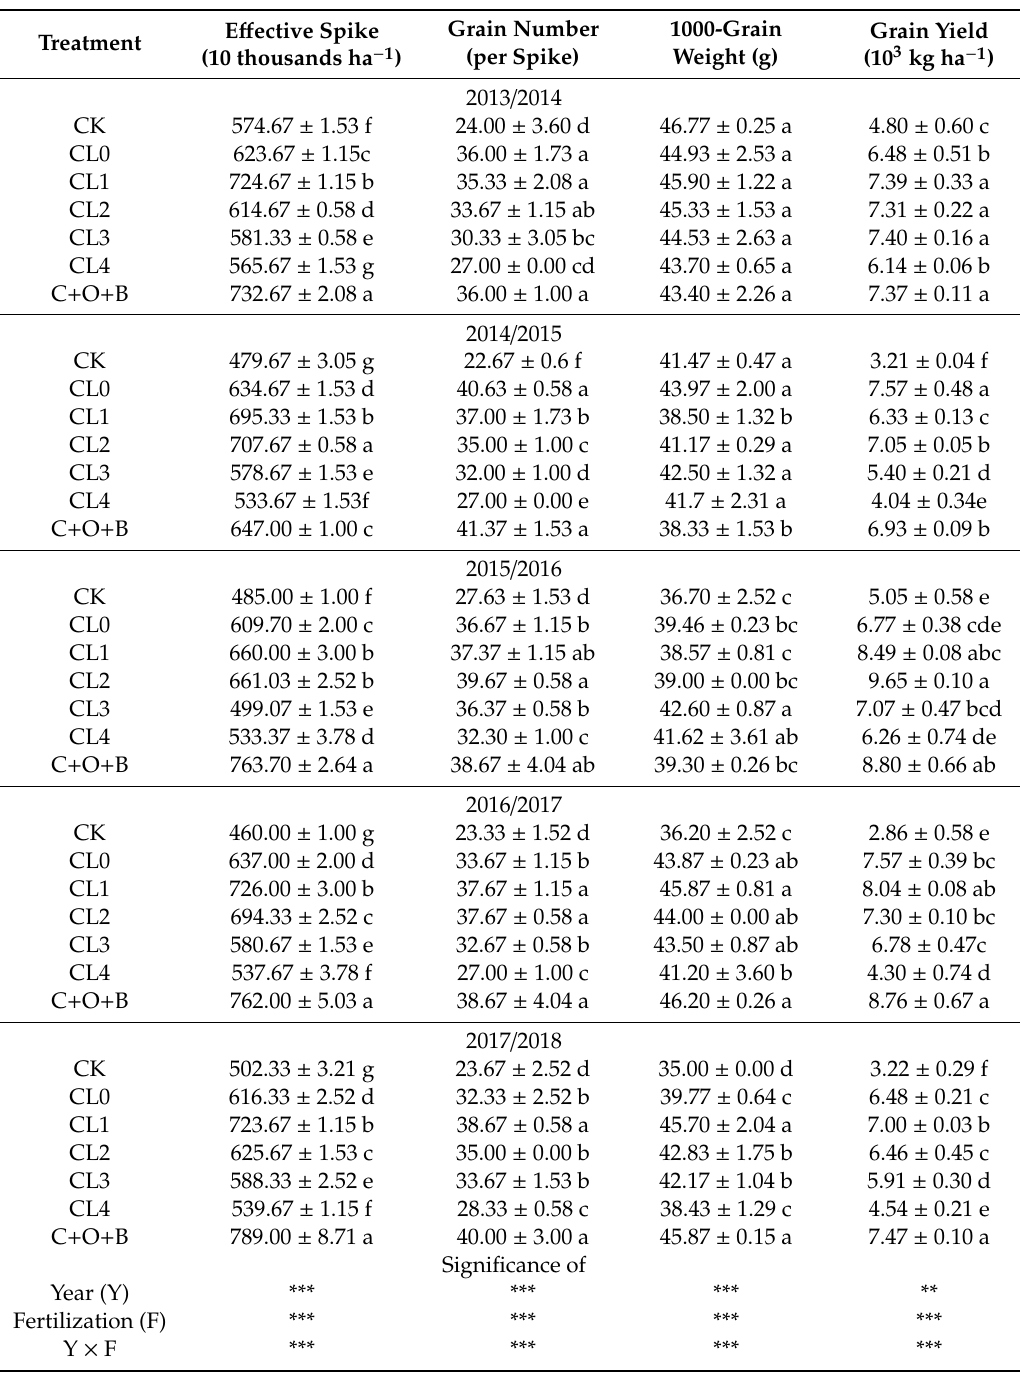
Table 3. Yield components of winter wheat yield parameters in di ff erent fertilization treatments during the 2013–2018 wheat growing seasons of China North